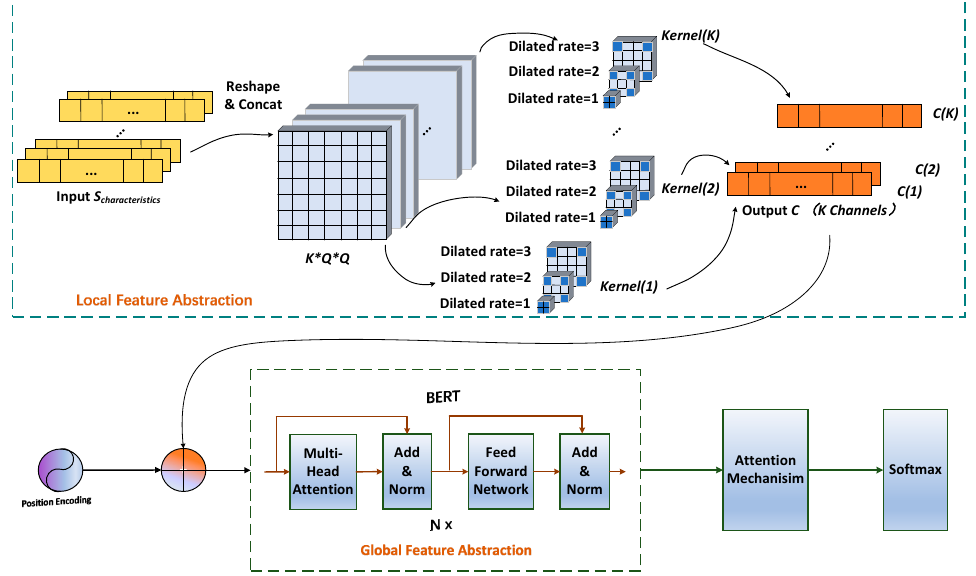
Figure 10. The schematic diagram of the measurement sequence feature extraction block DC-BERT.